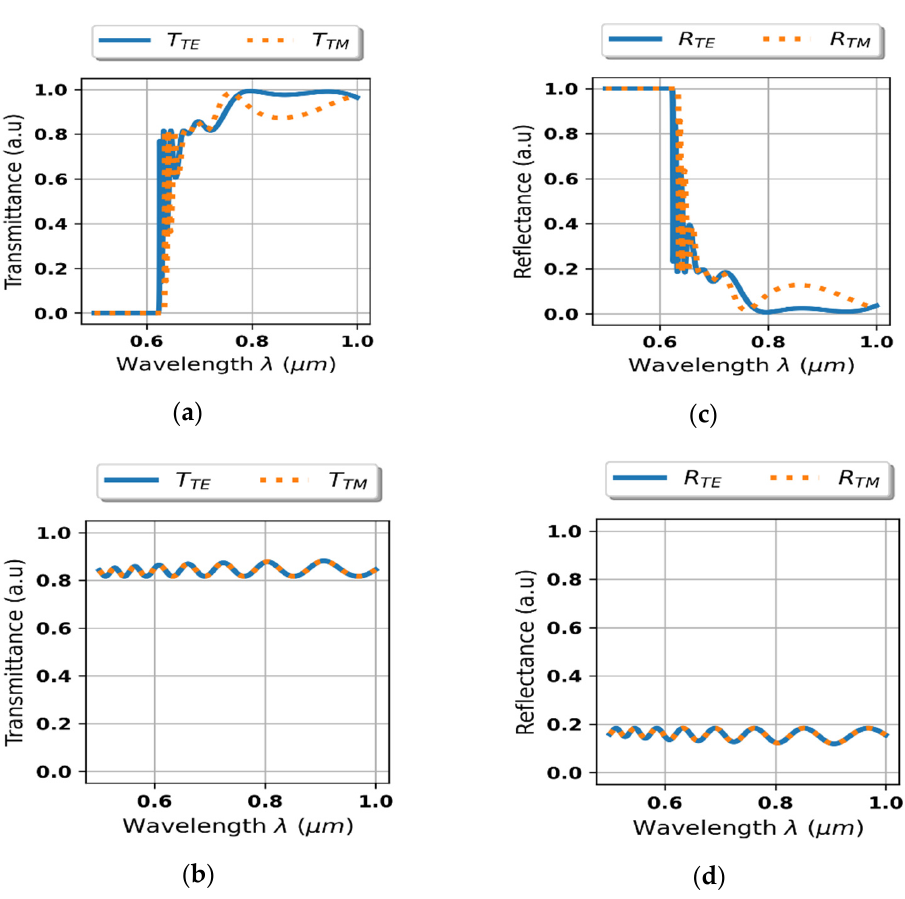
Figure 4. Transmittance ( a , b ) and reflectance ( c , d ) of the considered system with the HMM structure described via local ( b , d ) and non-local EMT approach ( a , c ).